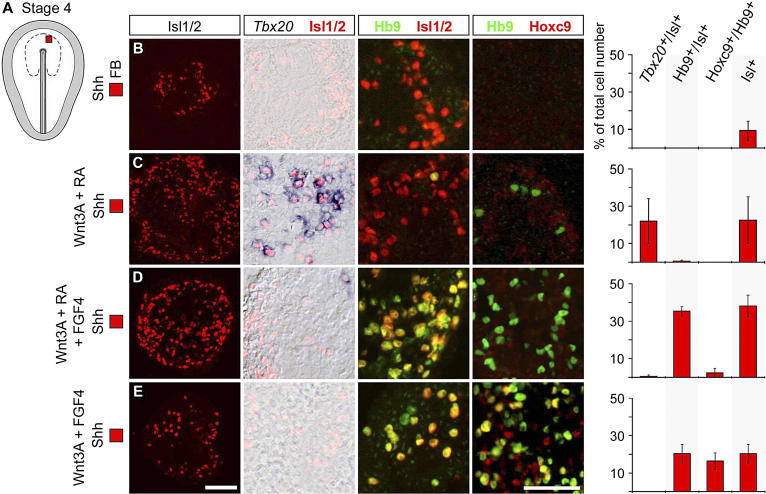
Hox Gene Profiles Induced by Wnt, RA, and/or FGF Signals Predict Later MN Subtype(A) Schematic drawing of a stage 4 embryo. Dotted line indicates the presumptive neural plate. Red box indicates prospective FB explants used for in vitro studies.(B–E) Explants were cultured alone or exposed to Wnt, RA, and/or FGF4 for 44 h, then washed and exposed to Shh-N (15 nM) for an additional 22 h. Bars represent mean ± s.e.m. number of
Tbx20
+/Isl
+, Hb9
+/Isl
+, and Hb9
+/Hoxc9
+ cells, respectively, as percentage of total cell number.
(B–E) Each row represents consecutive sections from a single explant.(B) Stage 4 FB explants cultured alone, before exposure of Shh-N, generated Isl
+ cells but no
Tbx20
+,
 Hb9
+, or Hoxc9
+ cells (
n = 6 explants).
(C) Stage 4 FB explants cultured in the presence of Wnt3A (˜150 ng/ml) and RA (10 nM), before exposure of Shh-N, generated
Tbx20
+/Isl
+ cells but no, or very few, Hb9
+/Isl
+ cells and no Hoxc9
+ cells (
n = 12 explants).
(D) Cultivation in the presence of Wnt3A (˜150 ng/ml), RA (10 nM), and FGF4 (30 ng/ml), before exposure of Shh-N, generated Hb9
+/Isl
+ cells and only a few
Tbx20
+/Isl
+ and Hb9
+/Hoxc9
+ cells (
n = 14 explants).
(E) Cultivation in the presence of Wnt3A (˜150 ng/ml) and FGF4 (60 ng/ml), before exposure of Shh-N, generated Hb9
+/Isl
+ and Hb9
+/Hoxc9
+ cells but no
Tbx20
+ cells (
n = 9 explants). Scale bars represent 100 μm (Isl) and 50 μm (double labels), respectively.